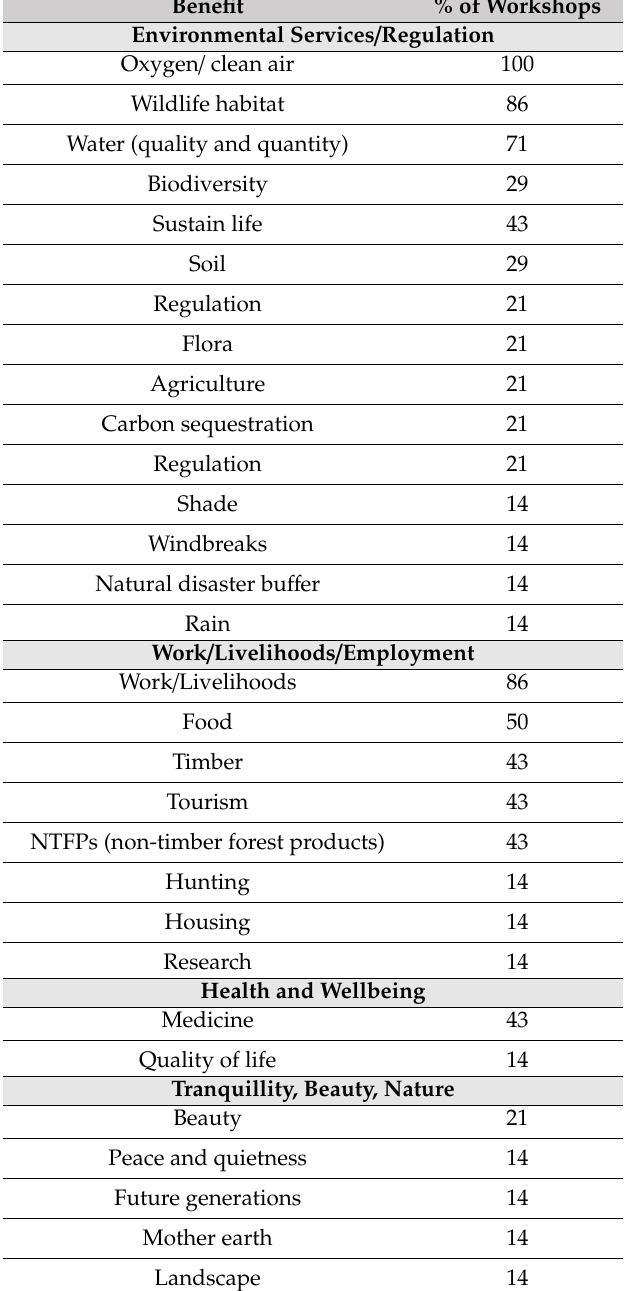
Table 6. The benefits of forests as identified by